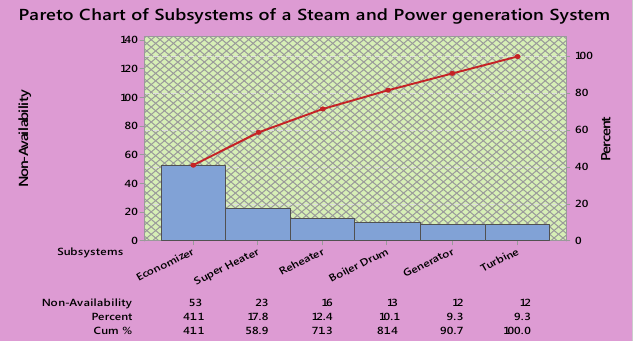
Fig. 5. Pareto Analysis of capacity waste factors (Non-Availability of